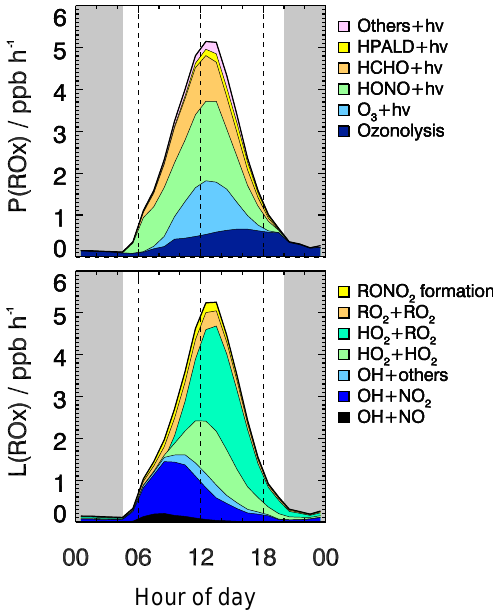
Figure 10. Hourly median diurnal profiles of modeled rates of pri- mary RO x production and termination reactions. Grey areas indicate